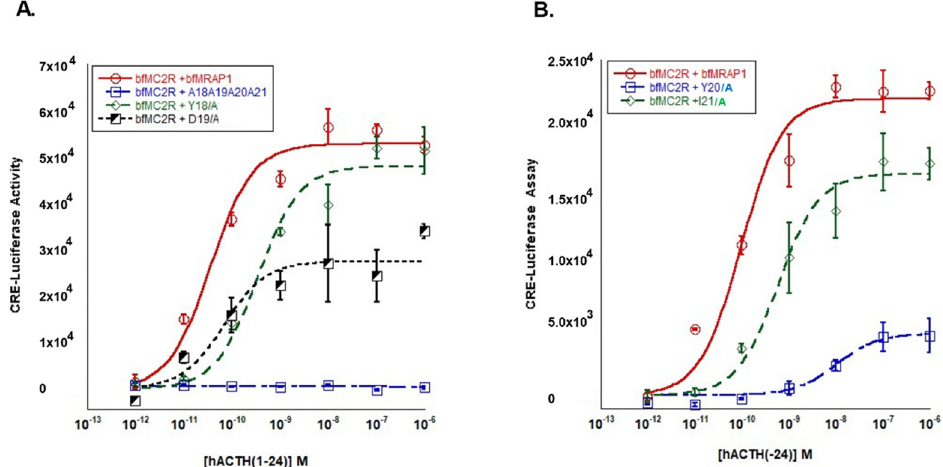
Figure 3. Analysis of Y 18 D 19 Y 20 I 21 motif in bowfin Mrap1. ( A ) Activation of bowfin (bf) Mc2r co- transfected with either wildtype bfmrap1 (positive control) or alanine substitution mutants of bfmrap1 : bfmrap1-a 18 a 19 a 20 a 21 , bfmrap1 − y 18 /a , or bfmrap1 − d 19 /a . ( B ) Activation of bfMc2r co-transfected with either wildtype bfmrap1 (positive control) or alanine substitution mutants of bfmrap1 : bfmrap − -y 20 /a